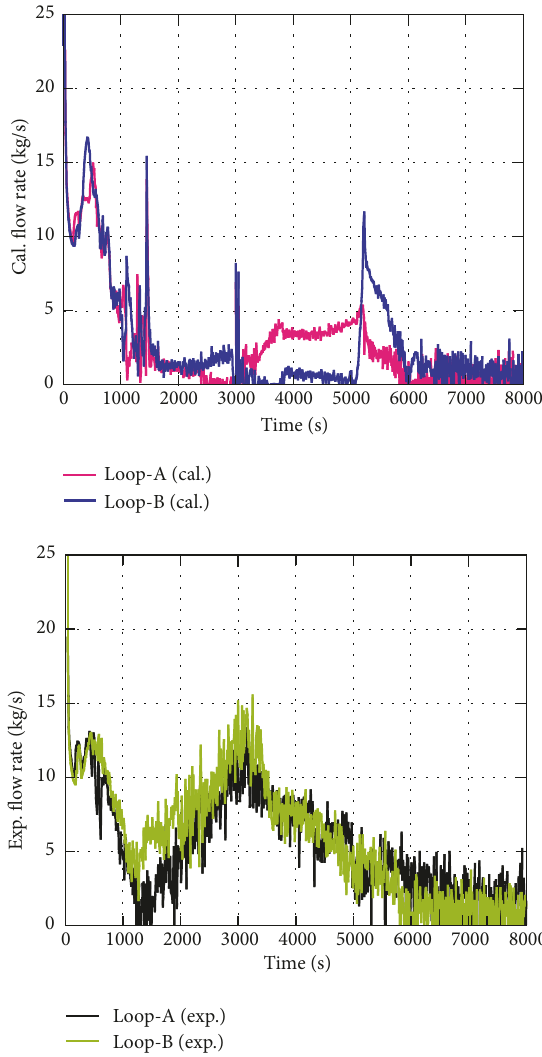
Figure 10: TR-LF-18 test and RELAP5 results for primary mass flow rate in each